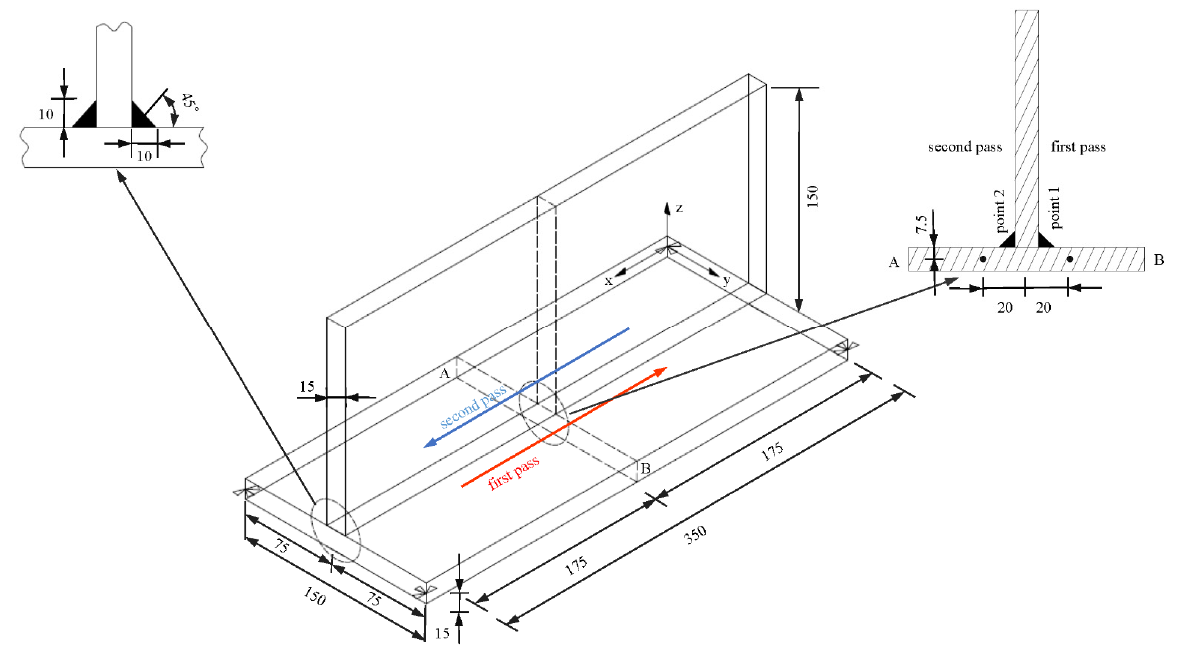
Figure 1. Geometry of the subject T-joint (unit: mm). Table 1. Main welding parameters. Table 2. Thermal properties of S355J2 + N steel.